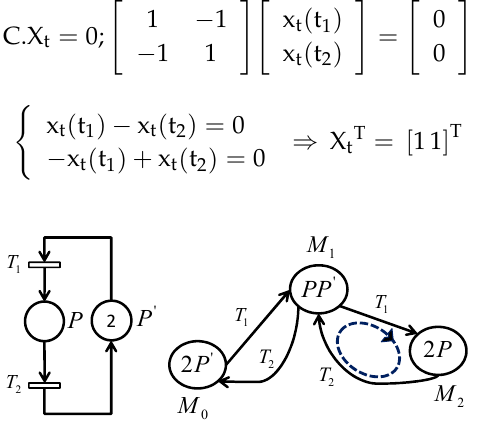
Figure 3. Example of PN with reachability graph.